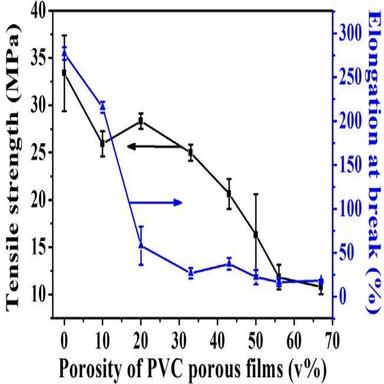
Tensile property of PVC films and PVC porous films.